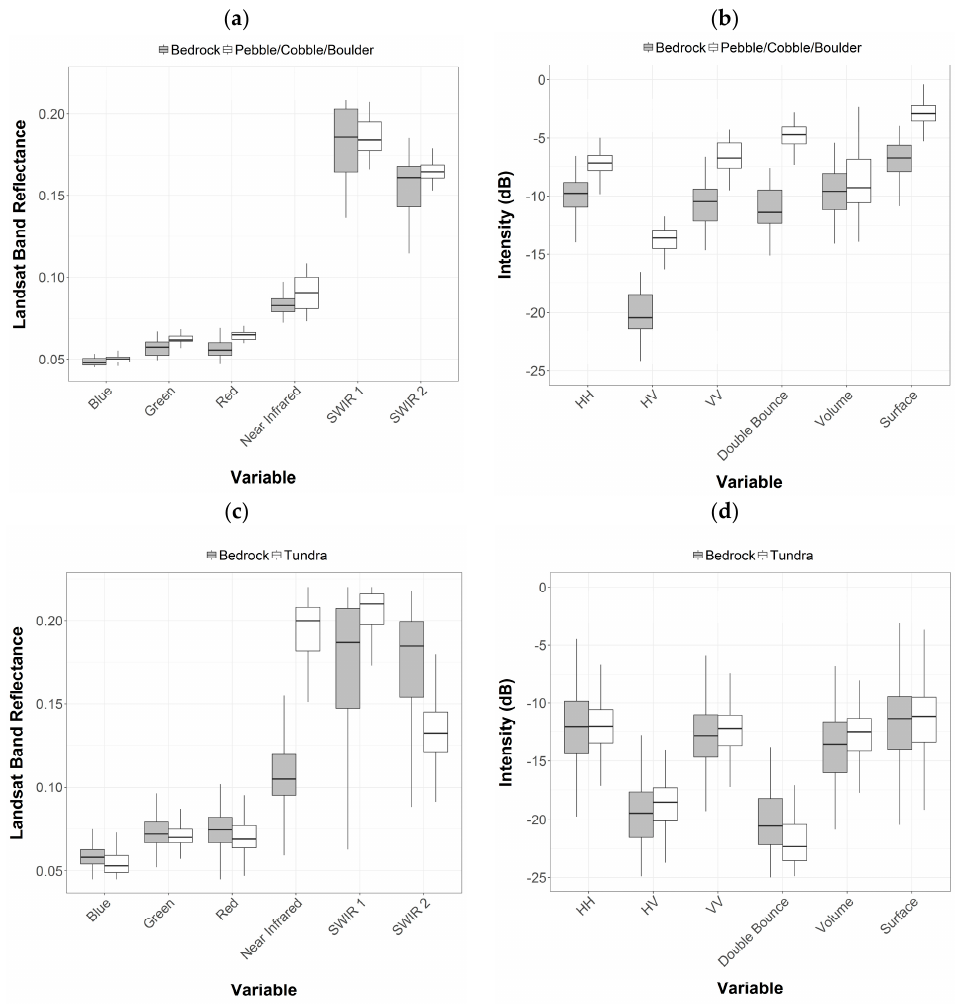
Figure 2. Box-and-Whisker plots (top = 25th percentile, middle = 50th percentile, bottom = 75th percentile, whiskers = 5th and 95th percentile) to show sample values for two shorelines composed of the same rock type but representing different shoreline classes (Bedrock and Pebble Cobble Boulder): ( a ) Landsat 5 band reflectance values; ( b ) quad pol RADARSAT-2 intensity, and Freeman–Durden decomposition values; and ( c , d ) for all training and validation sites for the Bedrock and Tundra class, Landsat 5 band reflectance values and quad pol RADARSAT-2 intensity, and Freeman–Durden decomposition values, respectively. Note that the range of values for Bedrock differ (i.e., among ( a – d )), which is due to the samples from ( a , b ) being from one location and rock type, while those for ( c , d ) were for all rock types sampled throughout the entire study area.